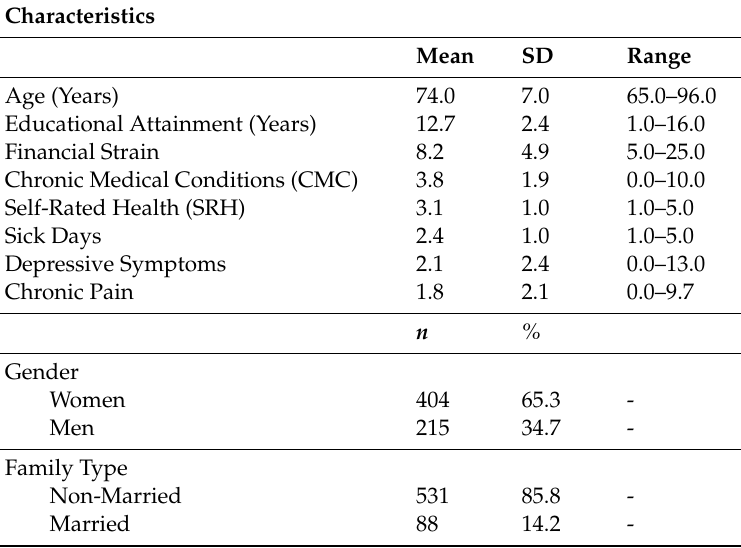
Table 1. Descriptive statistics ( n =